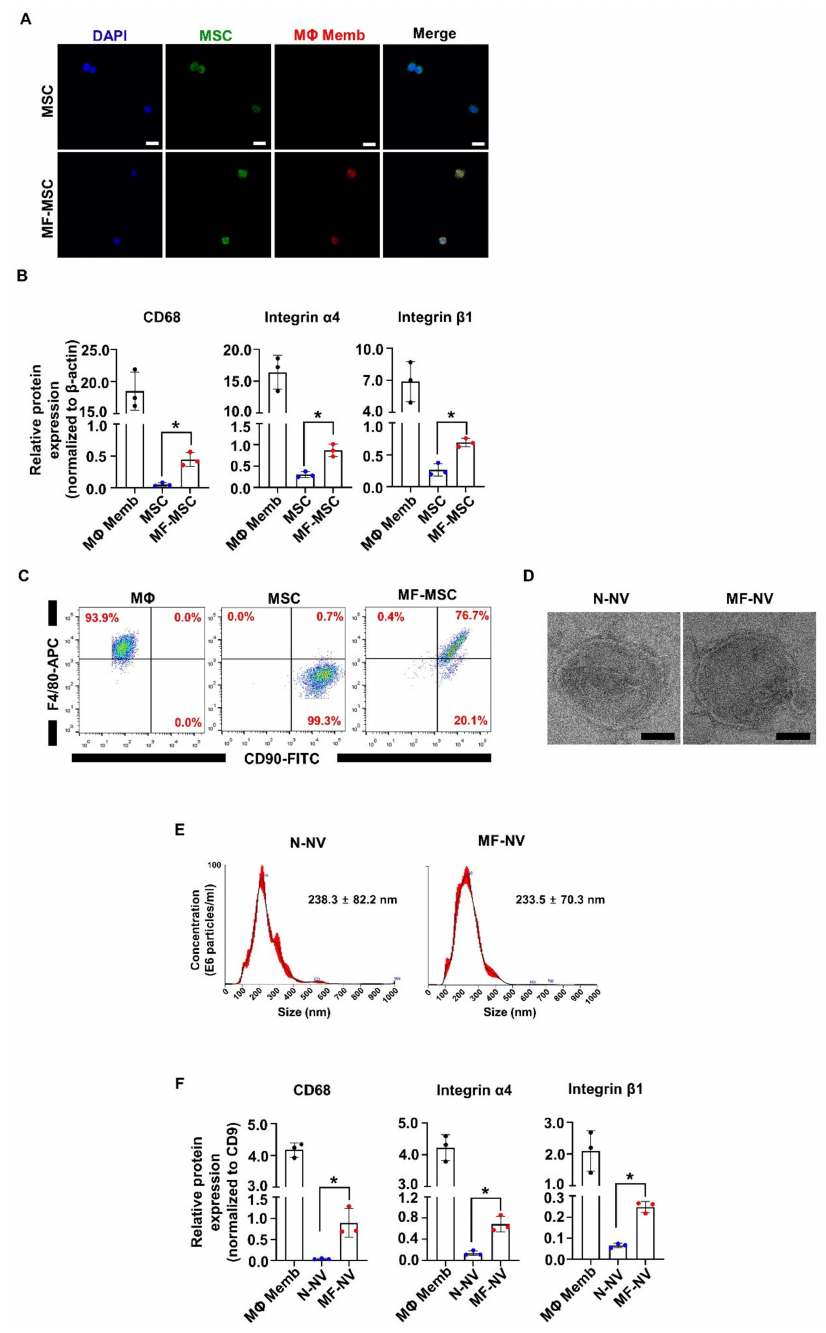
Figure 2. Characterization of MF-MSC and MF-NV. ( A ) Fluorescent confocal images of MSC and MF-MSC after fusion. Scale bars, 25 µ m. ( B ) The quantification of Western blots of surface markers of M Φ membrane (CD68, integrin α 4, and β 1), MSC, and MF-MSC (n = 3 per samples, 20 µ g of total proteins). ( C ) Flow cytometric analysis of MSC (CD90) and M Φ (F4 / 80) surface marker expressions on MF-MSC (n = 4 per samples). ( D ) Transmission electron microscopy of normal MSC-derived nanovesicles (N-NV) and MF-NV. Scale bars, 50 nm. ( E ) Size distribution of N-NV and MF-NV, as evaluated by nanoparticle tracking analysis (n = 4 per samples). ( F ) The quantification of Western blots of surface marker of M Φ membrane, N-NV, and MF-NV (n = 3 per samples, 20 µ g of total